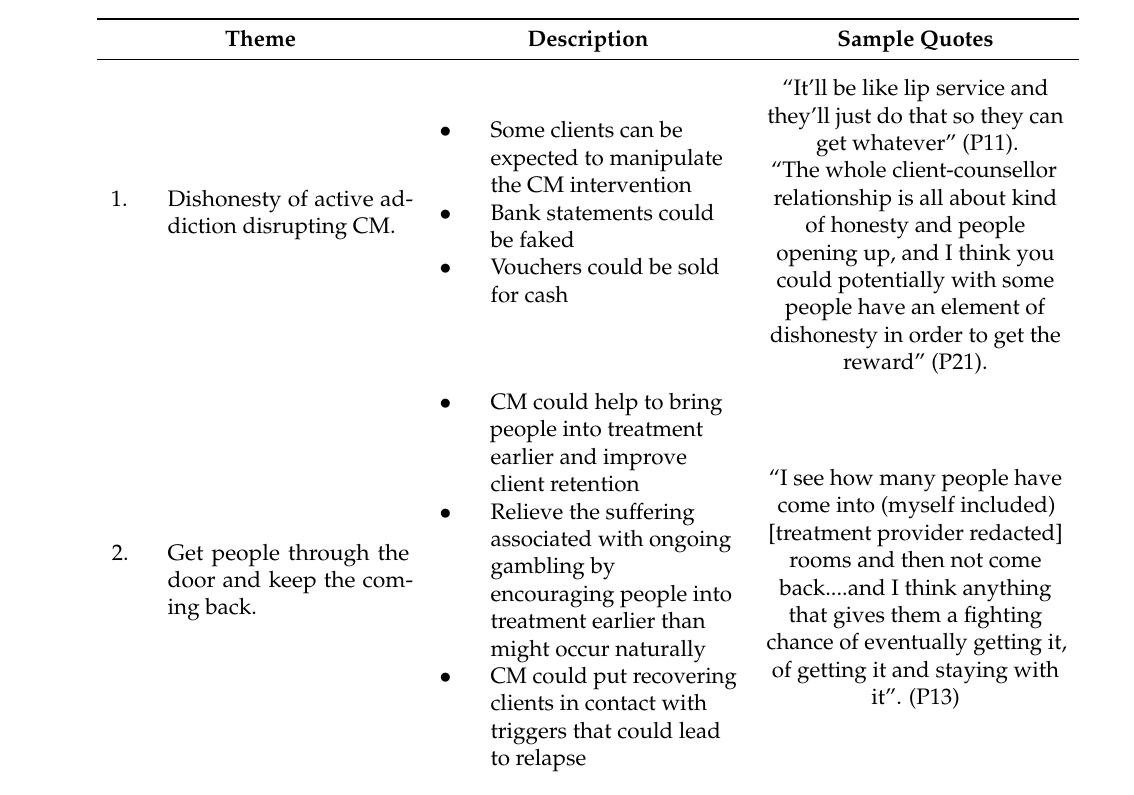
Table 3. Description of